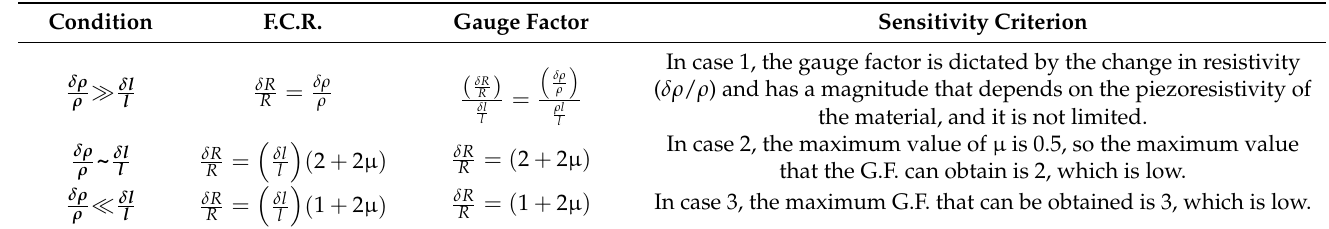
Table 8. The conditions adopted for determining